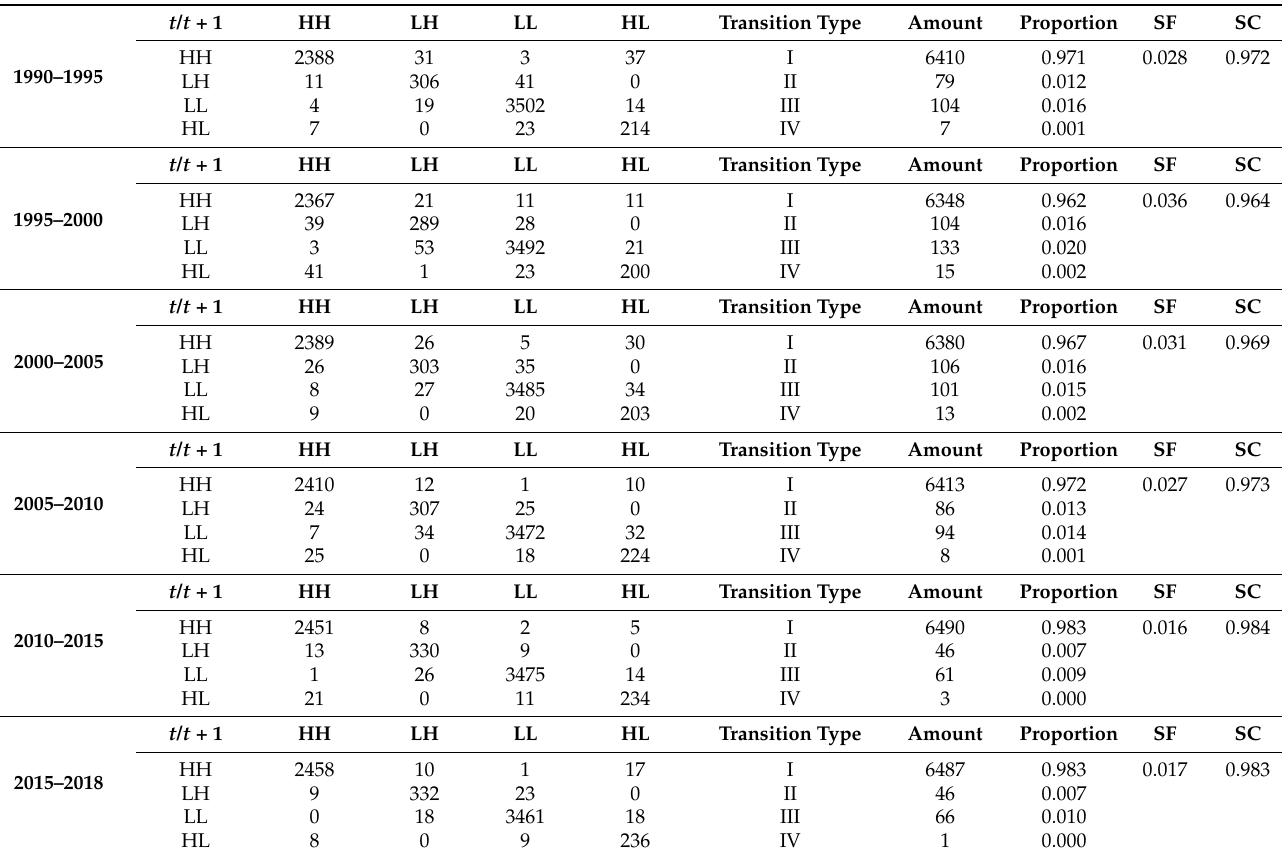
Table 4. Local Moran’s I transition matrix and spatiotemporal transition of ecosystem health at grid